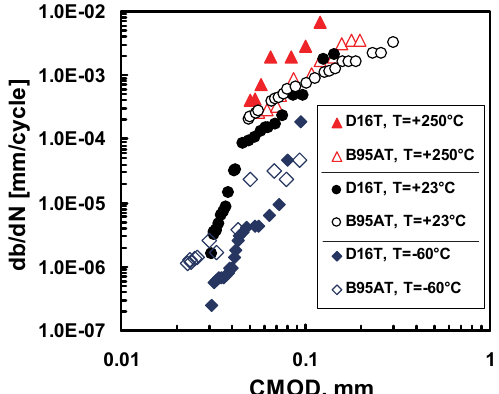
Figure 9: Crack growth rate on the free surface of hollow specimen versus CMOD for different temperature conditions.